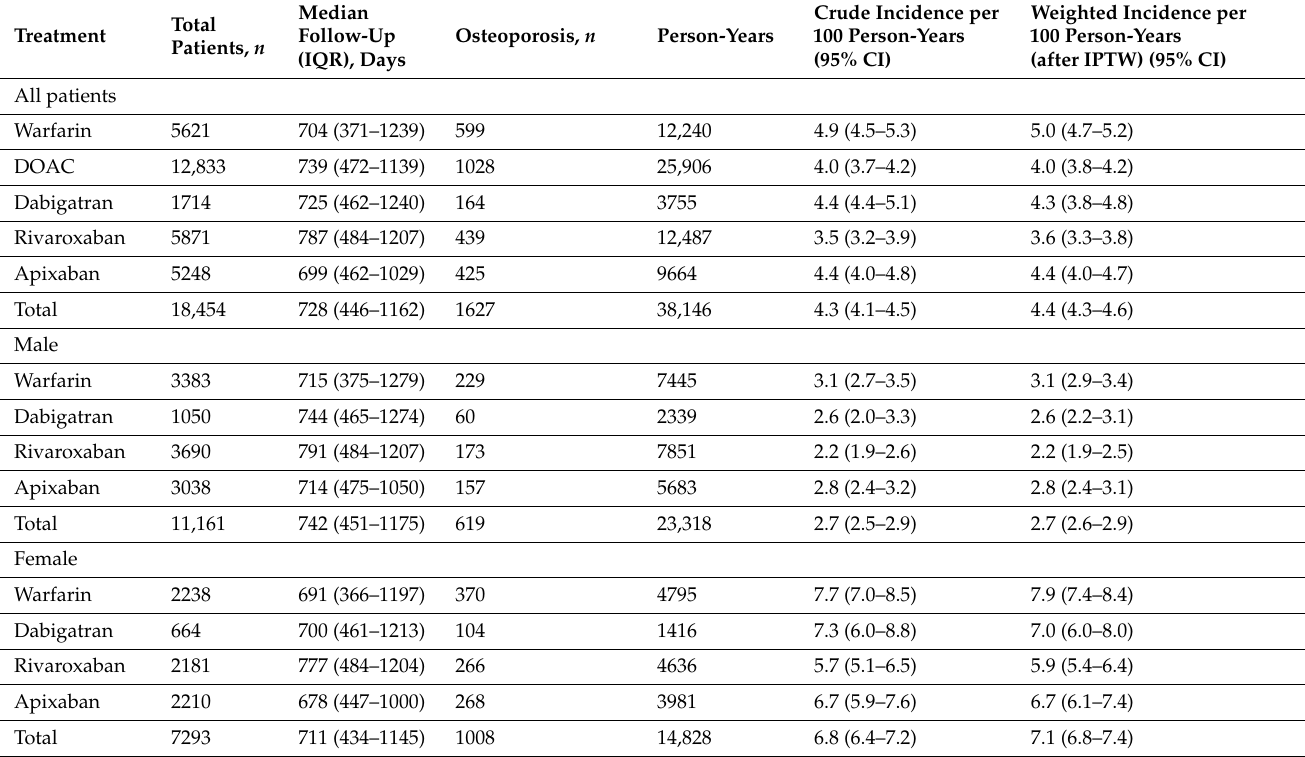
Table 2. The incidence of newly-diagnosed osteoporosis in the study cohort.